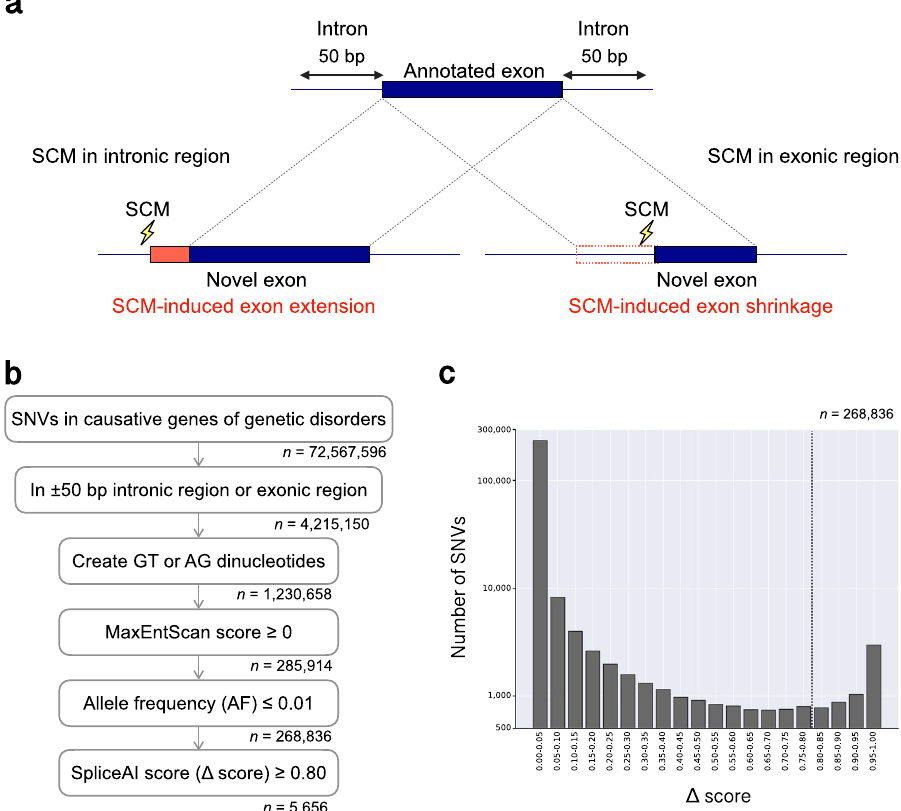
Fig. 1 Identi fi cation of splice-site-creating mutations in 4054 genes responsible for genetic disorders. a Schematic of novel exons by splice-site-creating mutations (SCMs). An exon extension by an SCM in the intronic region (left) and an exon shrinkage by an SCM in the exonic region (right). b Work fl ow for the identi fi cation of SCMs. Each number represents the number of SNVs at each step. c Distribution of SpliceAI scores ( Δ scores) for the 268,836 SNVs. The dotted line indicates the cutoff score (0.80) that we adopted for the potential